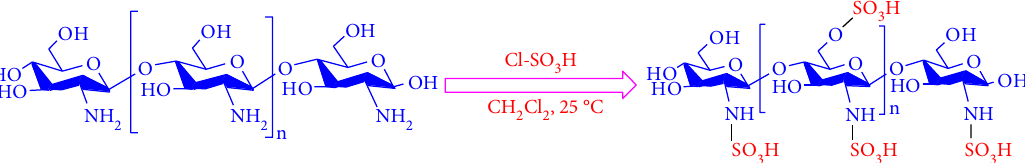
Table 3: Comparison of the performance of different heterogeneous catalysts in esterification.